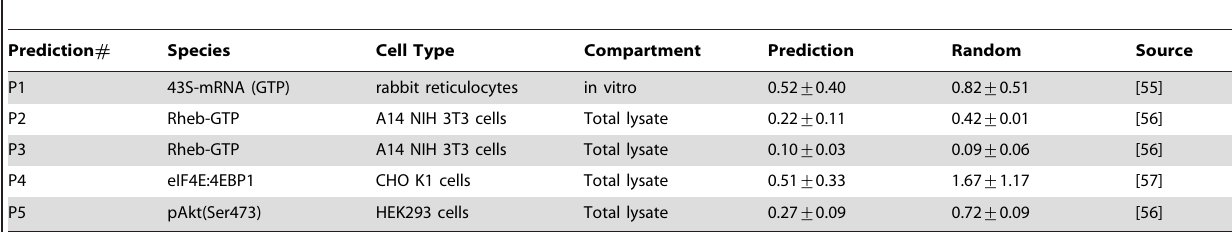
Table 2. Blind Prediction list along with species, cell type, prediction error, random error with a randomly generated parameter set and the corresponding literature